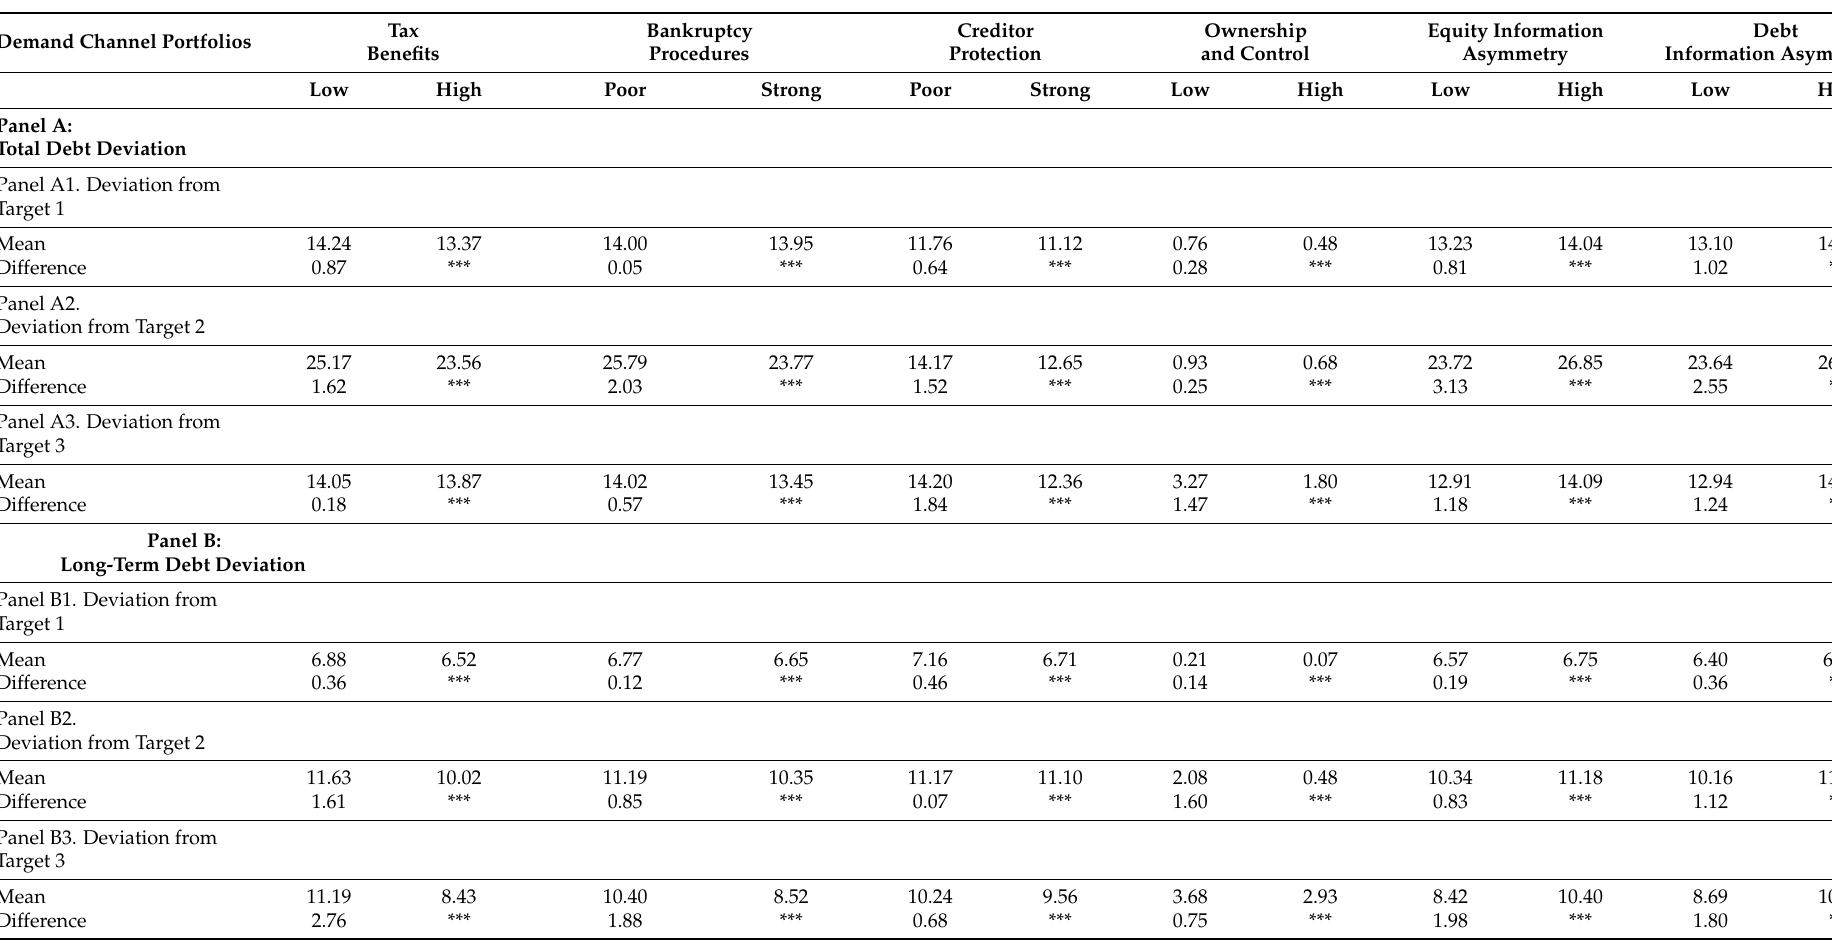
Panel B3. Deviation from Target